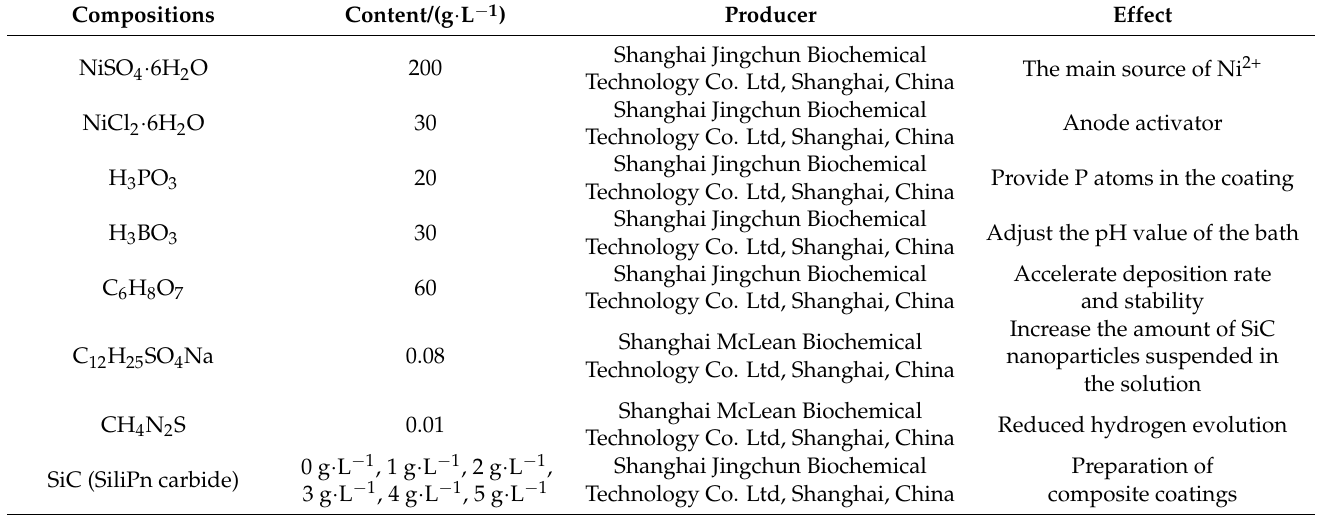
Table 4. Composition of the plating